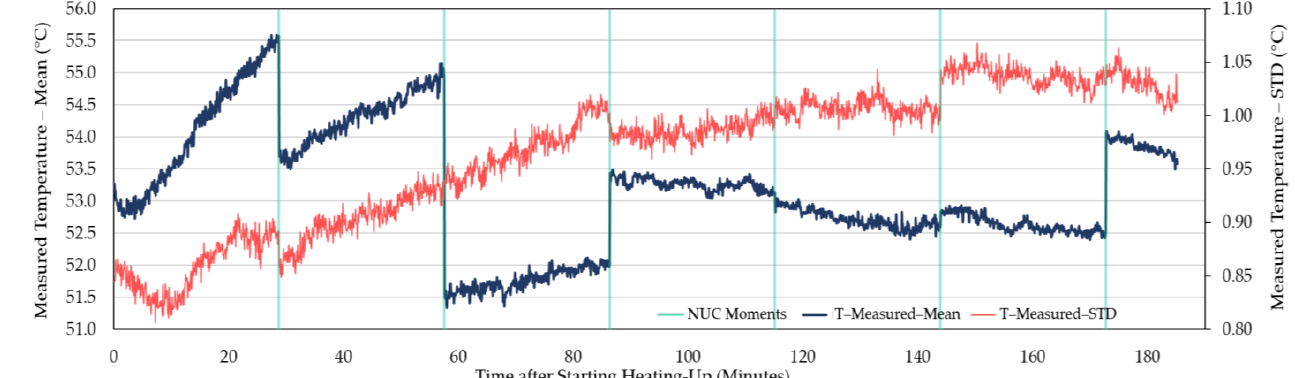
Figure 2. The original time series curves of WIRIS camera observations. Dark blue thick curve: Readings of the average measured temperature over time when imaging a round-shape blackbody calibrator at 55 °C, as recorded by WIRIS over 3 h after switching on the camera. During the operation of the camera, the emissivity of the measured object was adjusted from the default value of 0.95 to 0.98, being consistent with that of the adopted blackbody calibrator (Ε BB = 0.98). The thin red curve represents the development of the standard deviation (STD) of the temperature readings. The non-uniformity corrections (NUCs) every 30 min are shown as green lines.